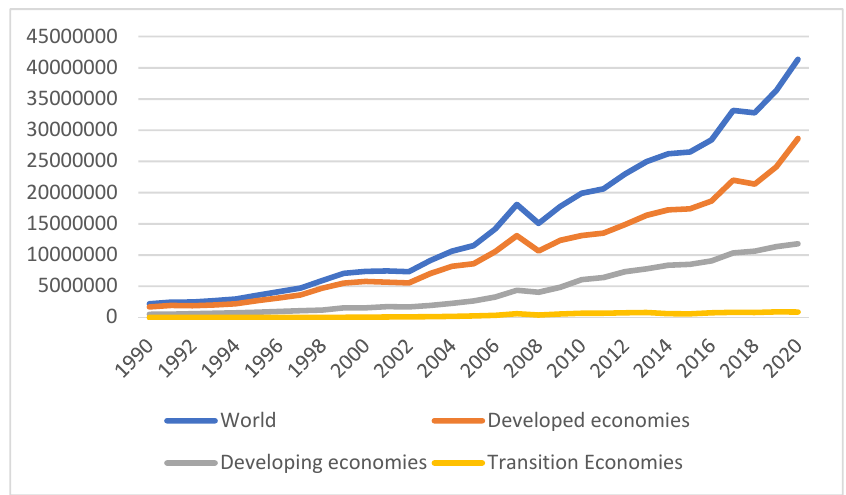
Figure 2. Development of inward FDI stock by groups of countries in millions of USD (own processing based on data from [42]).